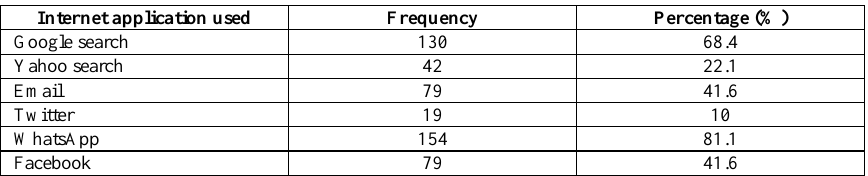
Head Teachers Responses on Internet Application